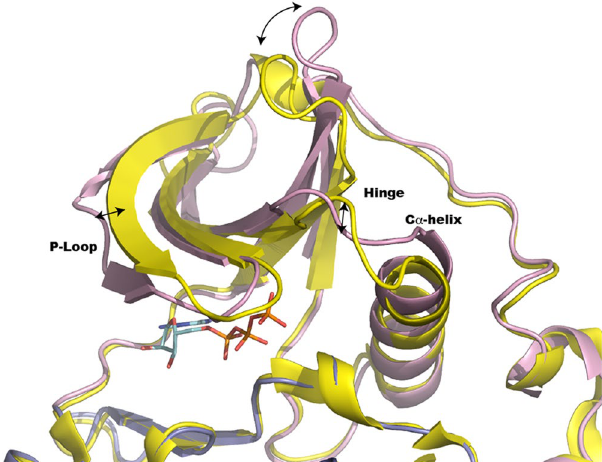
Figure 6. Conformational changes between the structure adopted by the N-Lobe of Pf CK2 α D179S (pink) and hCK2 (PDB code: 2PVR, yellow). A superposition of Pf CK2 α D179S (this work, colored in pink) and the active form of hCK2 (PDB code: 2PVR) shown in yellow. The three arrows show the main displacements described in the text at the level of the p-loop, Hinge and